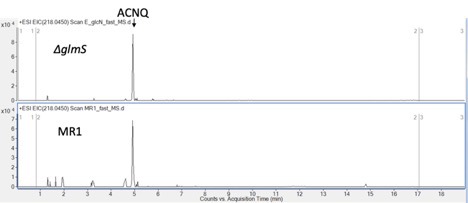
Production of ACNQ by S. oneidensis ΔglmS.Production level in ΔglmS mutant is consistent with WT when grown under the same condition (GlcNAc supplement).